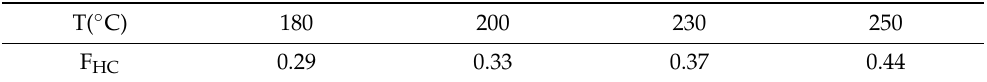
Table 3. Estimated values of fraction values F HC with respect to temperature [8]. T( ◦ C) 180 200 230 250 F HC 0.29 0.33 0.37 0.44 E a (13.91426 kJ/mol) represents the activation energy; A (0.45 min − 1 ) is the